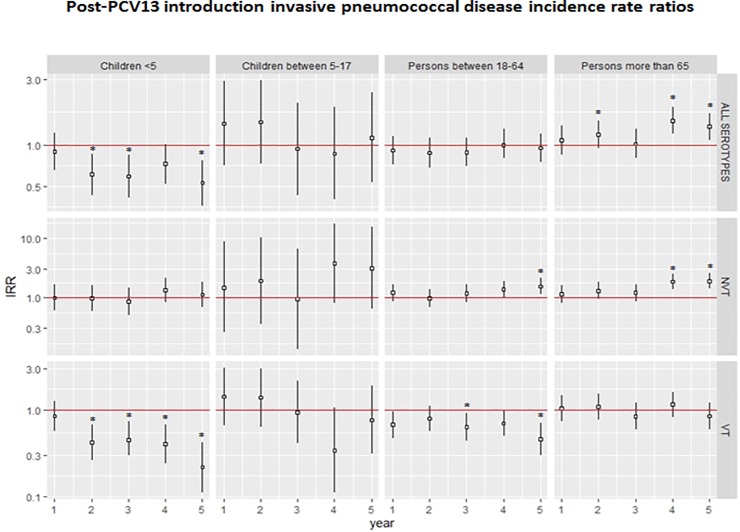
Post-PCV13 introduction invasive pneumococcal disease IRRs.Data are pooled IRRs. IRRs were estimated by comparing observed incidence (in each of the years 2012 to 2016) to expected (incidence in 2011) for each age-serotype group. 95% CIs presented on a logarithmic scale by error bars. Year 1 to 5 represents years encompassed from 2012 to 2016.